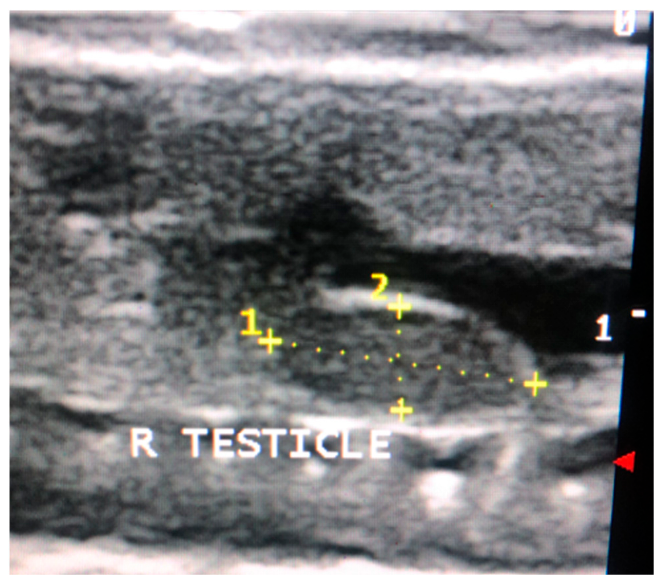
Figure 2. Right testicular measurement on ultrasound.